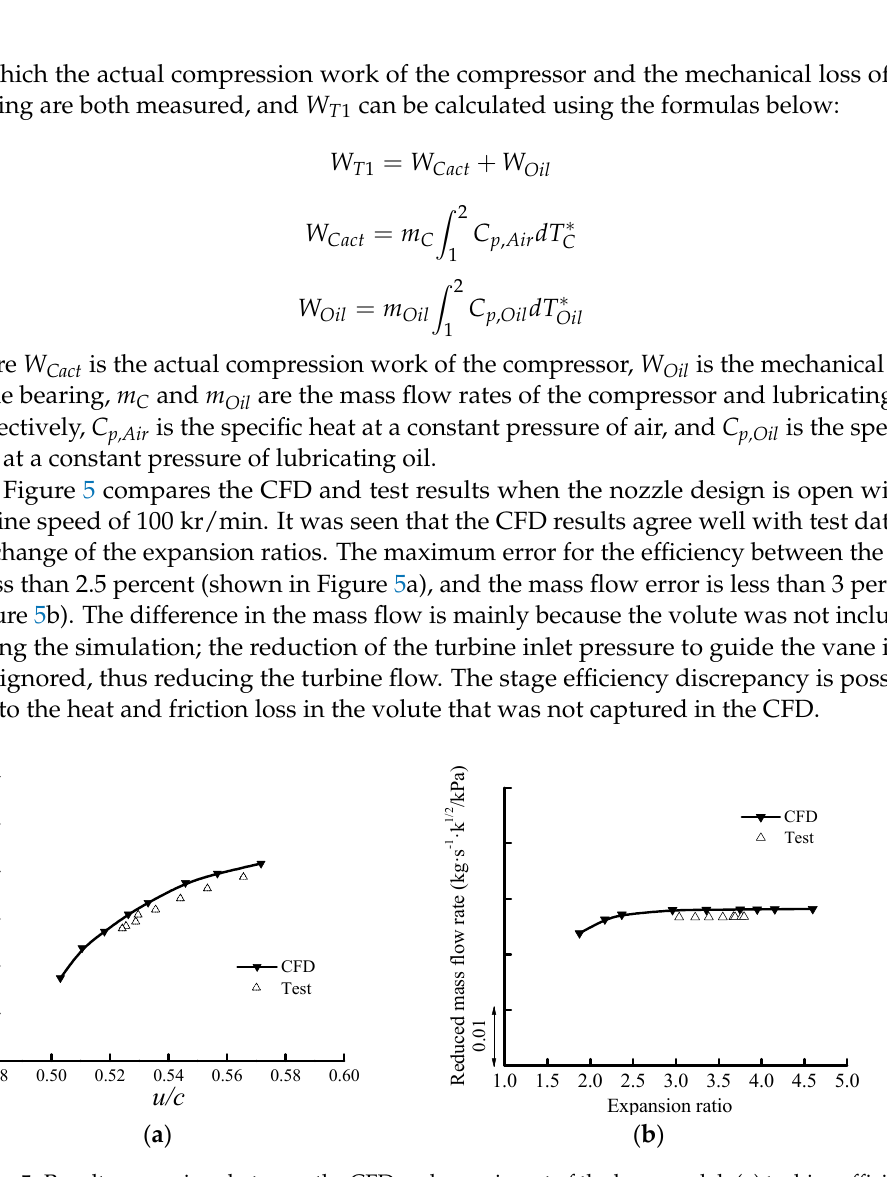
Figure 5. Result comparison between the CFD and experiment of the base model: ( a ) turbine efficiency characteristics; ( b ) turbine mass flow characteristics.